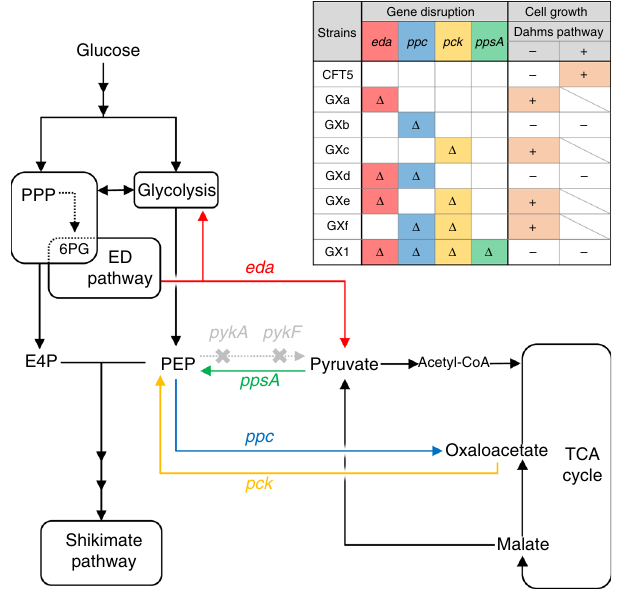
Fig. 3 Metabolic pathway and growth of CFT5-derived strains. Δ indicates gene disruption. Orange highlighted + indicates that the strain grew in M9 minimal medium with glucose as the sole carbon source. ED pathway Entner – Doudoroff pathway; PEP phosphoenolpyruvate; E4P erythrose 4- phosphate; and 6PG 6-phosphogluconate.